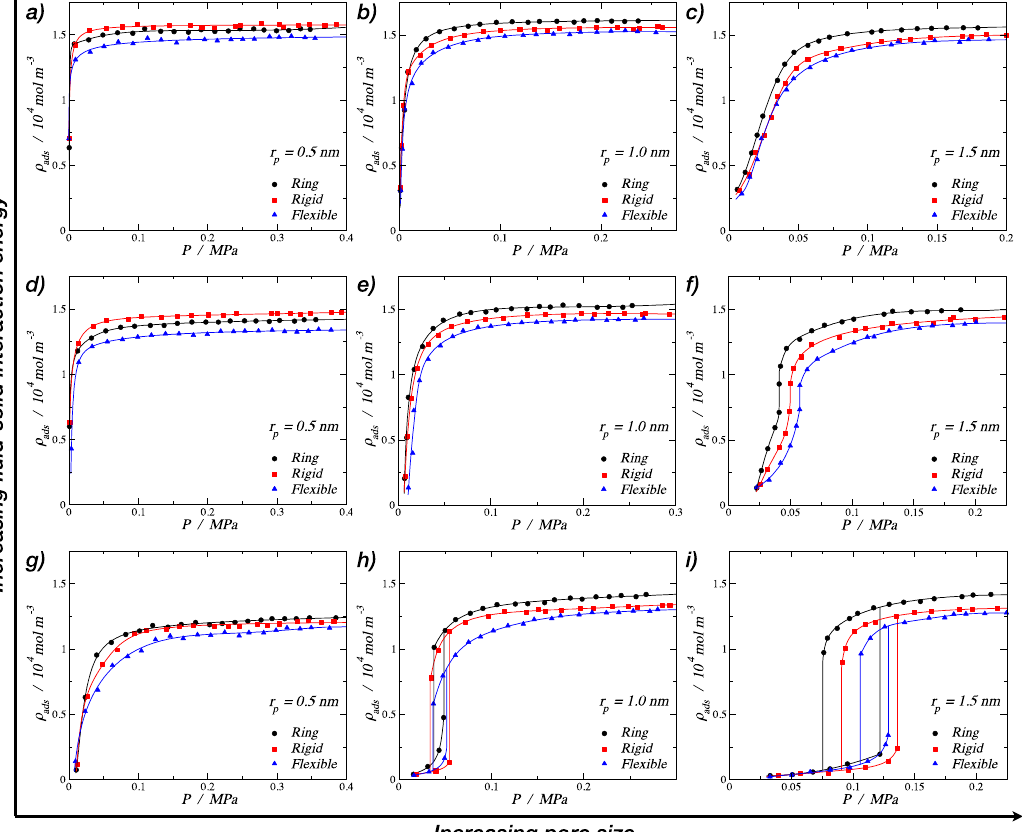
Figure 5. Adsorption isotherms at 150 K for trimers in a cylindrical pore. The top row corresponds to a strong fluid–solid energy interaction of ε p/ k b = 25.0 K per particle: ( a ) r p = 0.5 nm, ( b ) r p = 1.0 nm, and ( c ) r p = 1.5 nm. The middle row corresponds to the medium fluid–solid energy interaction of ε p/ k b = 19.3 K per particle: ( d ) r p = 0.5 nm, ( e ) r p = 1.0 nm, and ( f ) r p = 1.5 nm. The lower row corresponds to the weak fluid–solid energy interaction of ε p/ k b = 13.8 K per particle: ( g ) r p = 0.5 nm, ( h ) r p = 1.0 nm, and ( i ) r p = 1.5 nm. In all cases, the symbols in the isotherms correspond to rings (filled black circles), rigid linear chains (filled red squares), and fully flexible chains (filled blue triangles). Solid lines are empirical nonlinear fits. Error bars are of the size of the symbols.